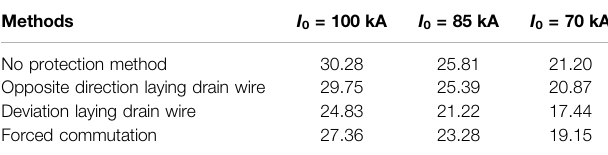
TABLE 1 | In fl uence of methods on pipeline